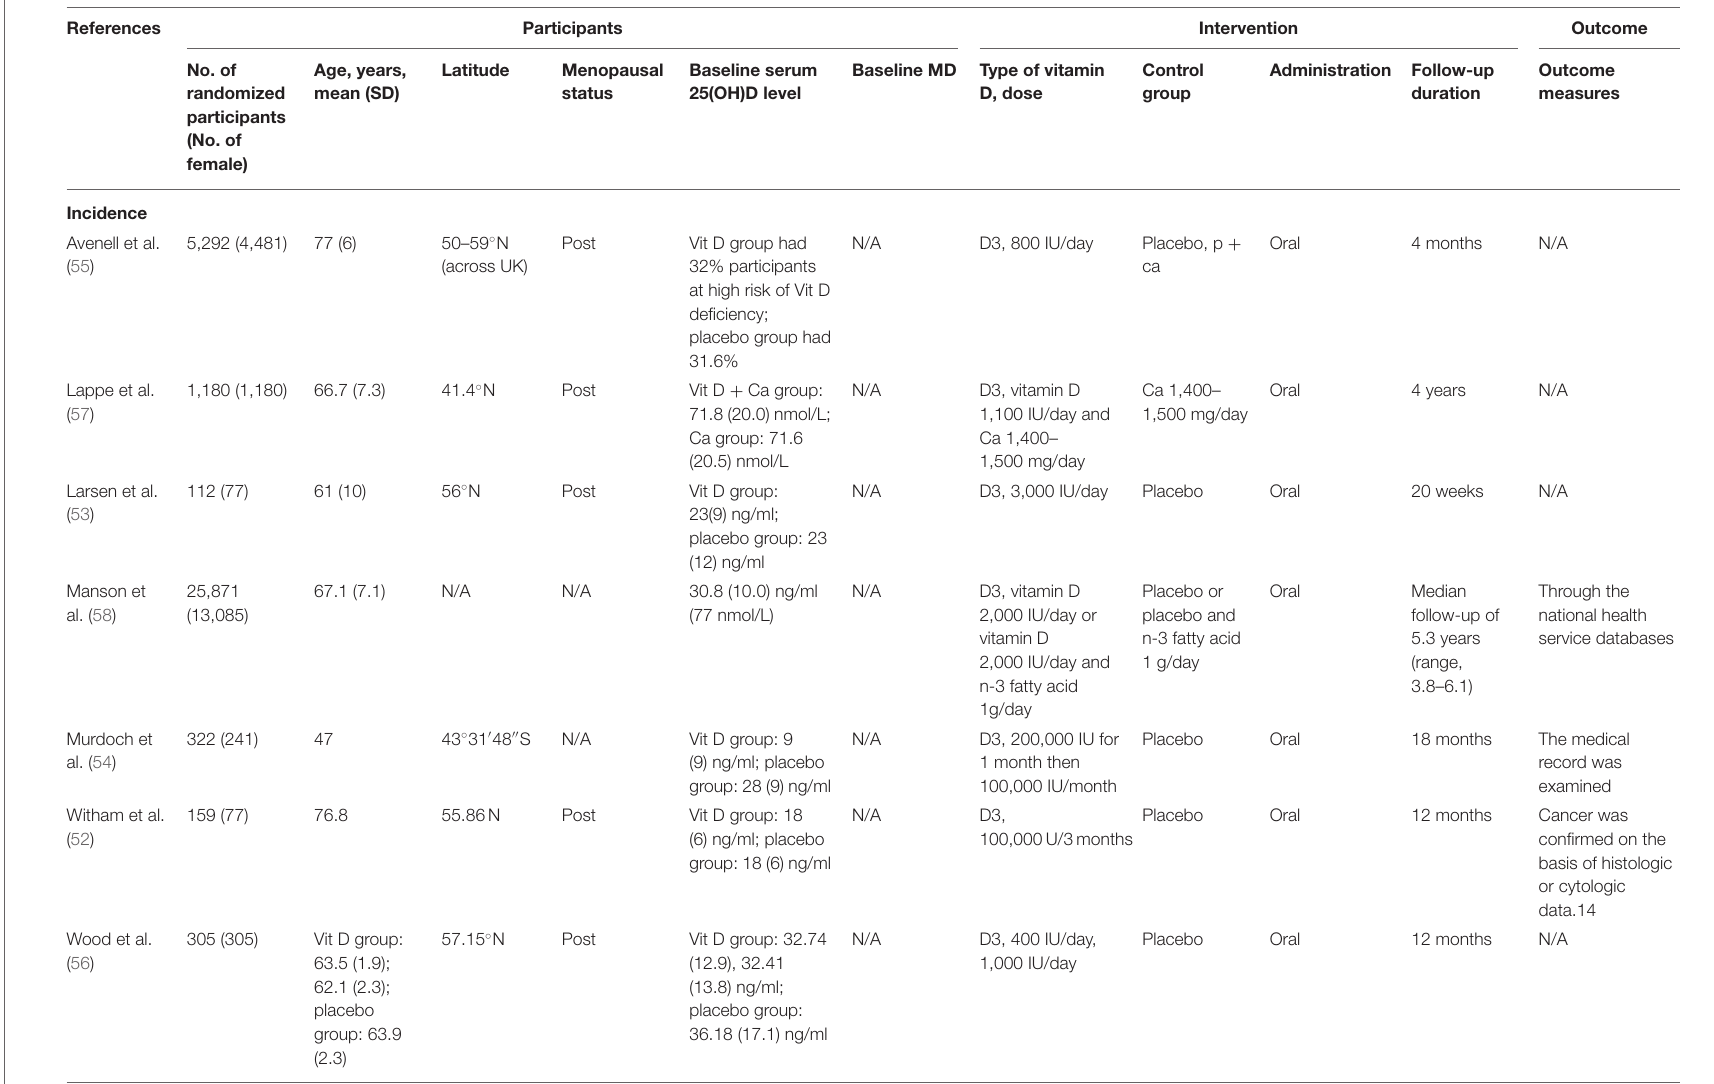
TABLE 1 | Characteristics of included